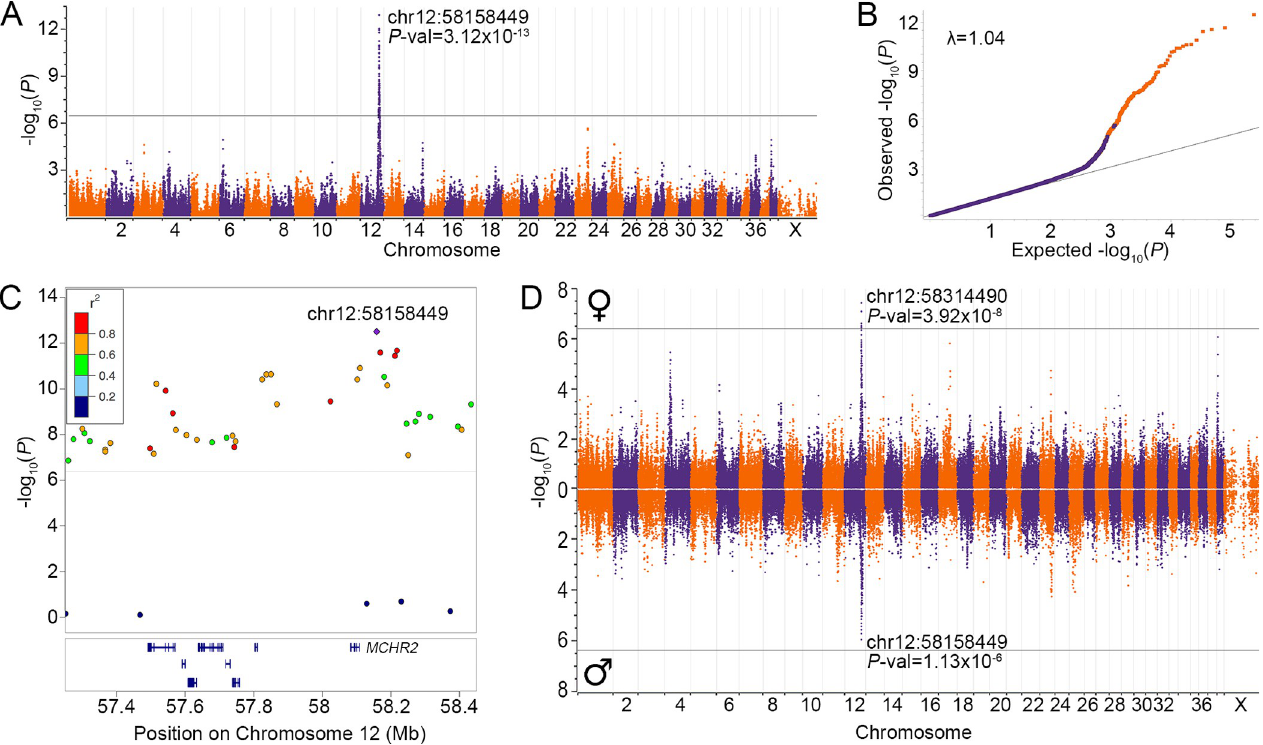
Fig 3. Genome-wide association results for CIM in GSDs. A) Manhattan plot of results from a GWAS for CIM using 59 affected and 53 control GSDs, with sex as a covariate. The –log 10 P -vals for 117,451 SNPs are plotted against genome position (CanFam3.1), with Bonferroni significance denoted by the black horizontal line. The P -val and position of the lead SNP are given. B) A Q-Q plot shows observed vs. expected –log 10 P -vals, with 454 SNPs within 5 Mb of the lead SNP indicated in orange. The genomic inflation factor ( λ ) is given. C) Regional chromosome 12 GWAS results are color-coded based on pairwise LD (r 2 ) with the lead SNP (purple diamond), calculated using all 53 controls. The positions of protein-coding genes within the region are indicated by blue bars below, with MCHR2 labeled. D) Miami plot of results from independent GWASs for CIM in females (top; 24 cases, 35 controls, λ = 1.042) and males (bottom; 35 cases, 18 controls, λ =